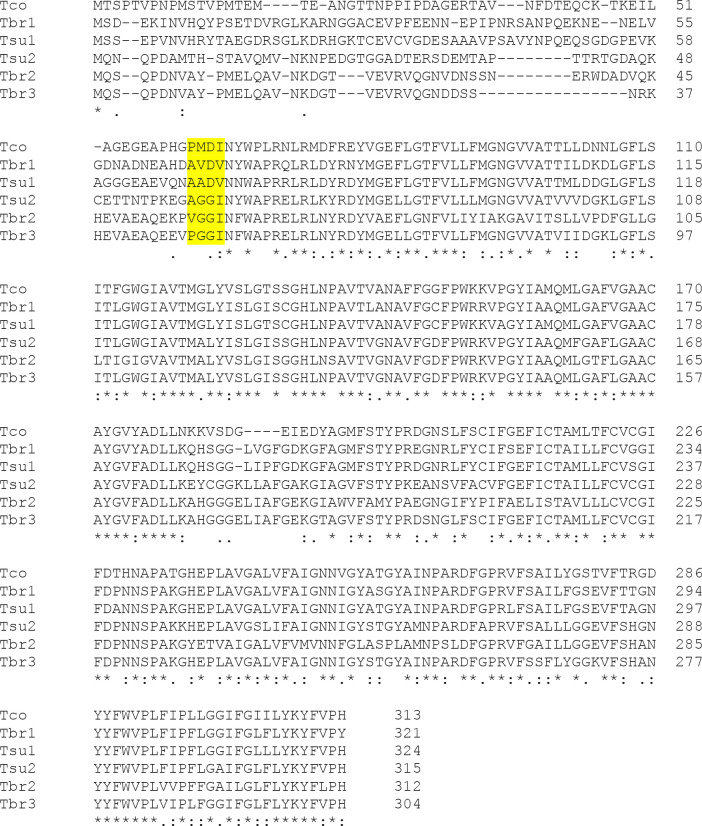
Sequence alignment and individual sequences of the T. congolense, T. b. brucei and T. suis.The T. brucei and T. congolense sequences were obtained from tritrypDB, T. suis sequences (Kelly S, Gibson W and Carrington M. The genome of Trypanosoma suis. In preparation). The alignment was produced with Clustal Omega. The yellow highlighting indicates the N-terminus of the sequences used to determine non-synonymous v synonymous ratios. dN/dS. T brucei AQP1 v T. suis AQP1 0.21. T brucei AQP3 v T. suis AQP3 0.30. T brucei AQP2 v T. brucei AQP3 2.00.